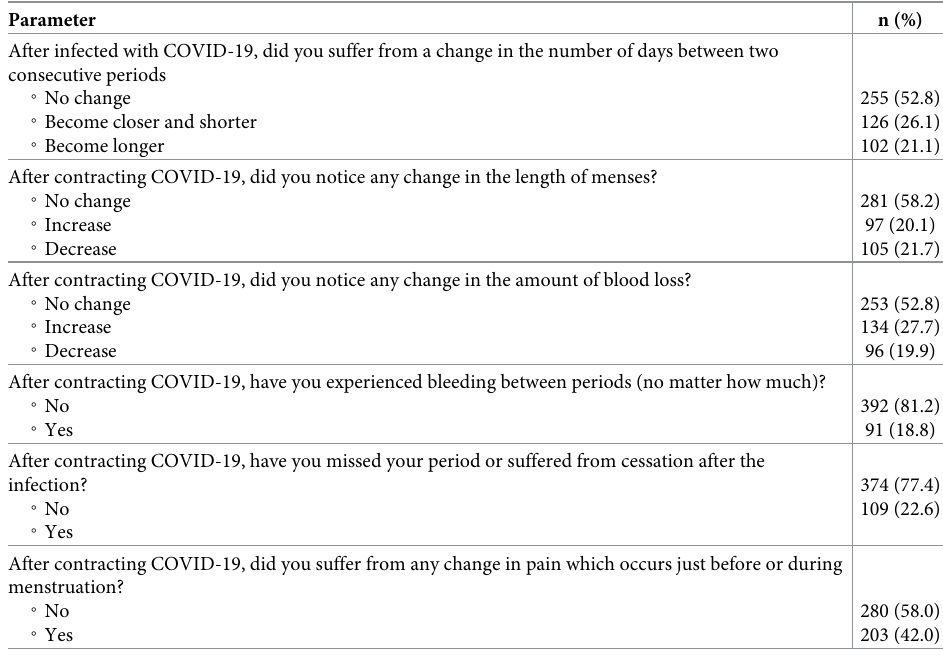
Table 3. Menstrual cycle changes which occurred after COVID-19 infection (n = 483). Parameter n (%) After infected with COVID-19, did you suffer from a change in the number of days between two consecutive periods ◦ No change ◦ Become closer and shorter After contracting COVID-19, did you notice any change in the length of menses? ◦ No change